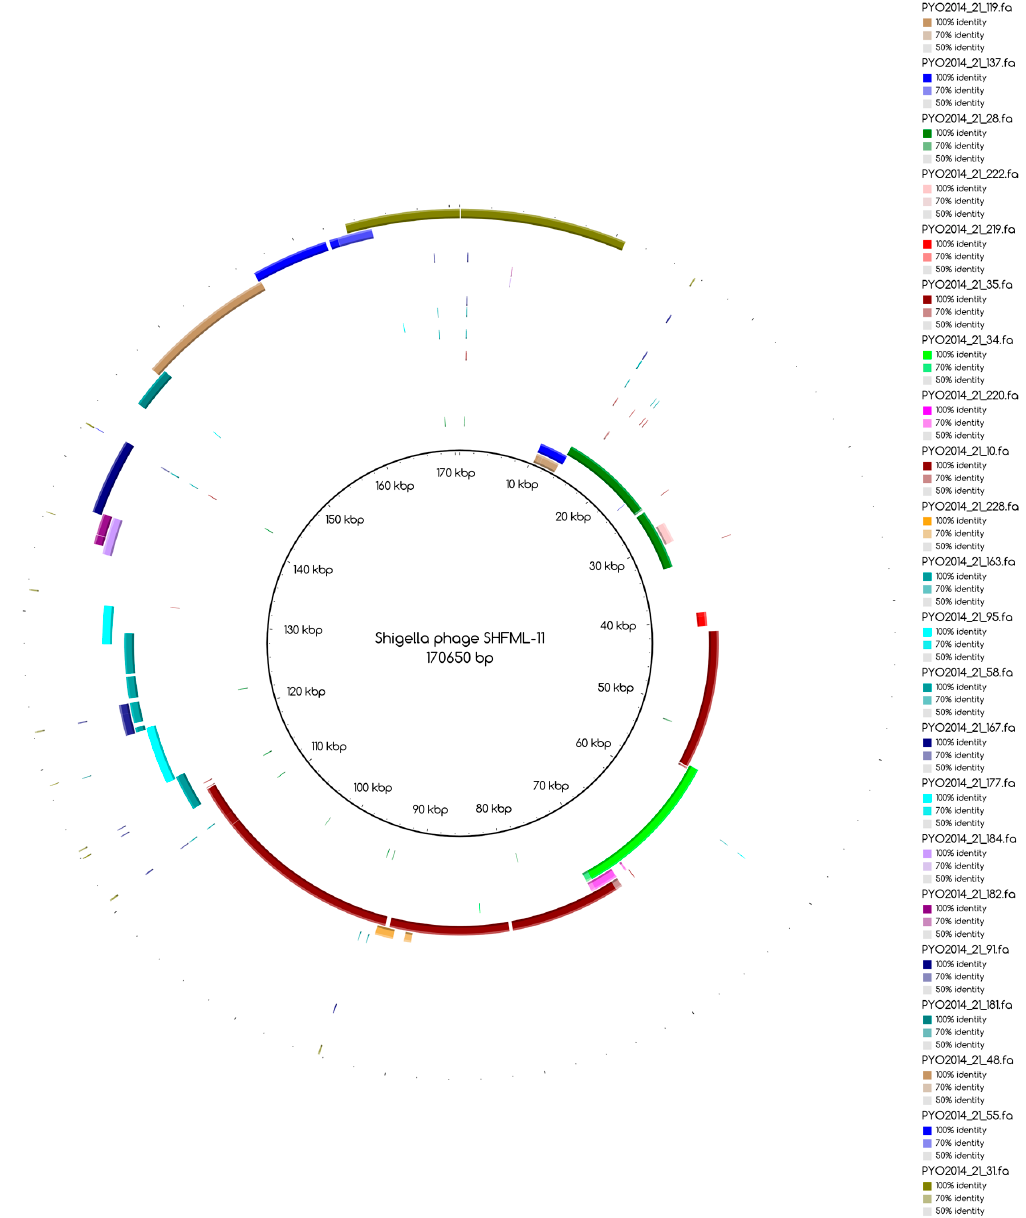
Figure A1. Blast Atlas of PYO2014_21 towards the reference Shigella phage SHFML-11.